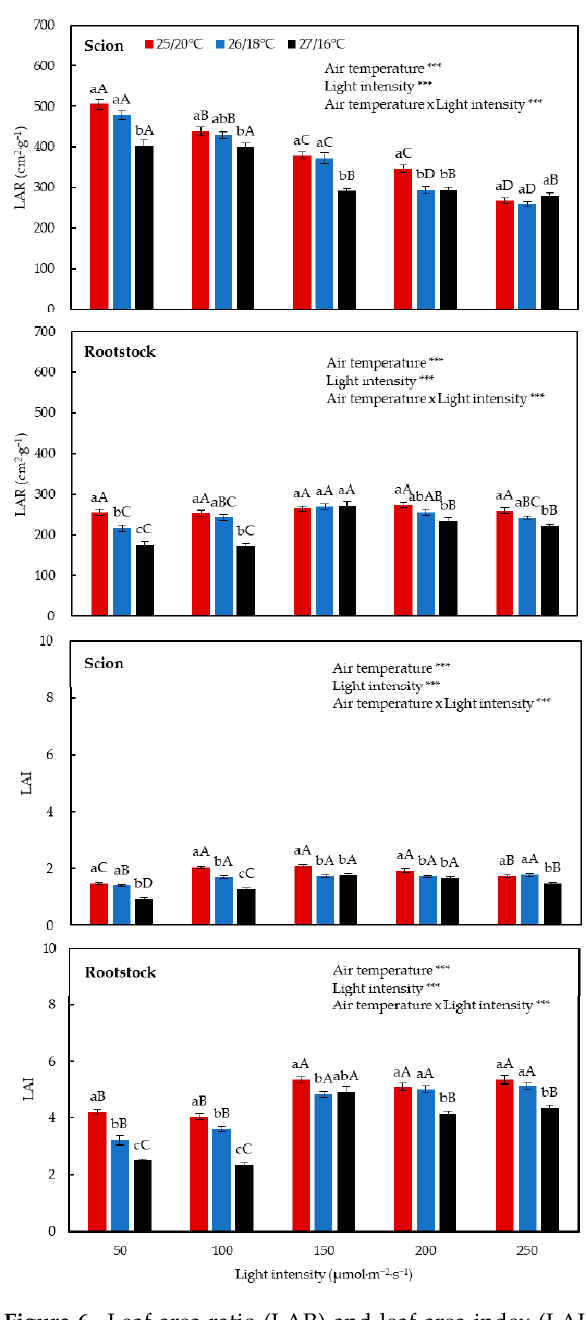
Figure 6. Leaf area ratio (LAR) and leaf area index (LAI) of cucumber scions and rootstocks as affected by the different air temperature and light intensity treatments in a PFAL. The error bar indicates the standard error of the mean for 3 replicates with 7 samples. *** indicates significant differences at p < 0.001. Values with different letters differ significantly at the 95% level according to Tukey’s HSD test. Lowercase letters compares air temperature treatments for each light intensity treatment. Uppercase letters compare light intensity treatments for each air temperature